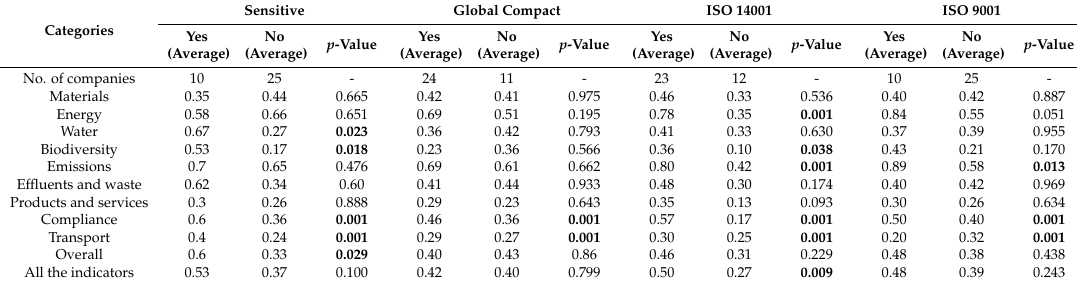
Table 4. Mann-Whitney test